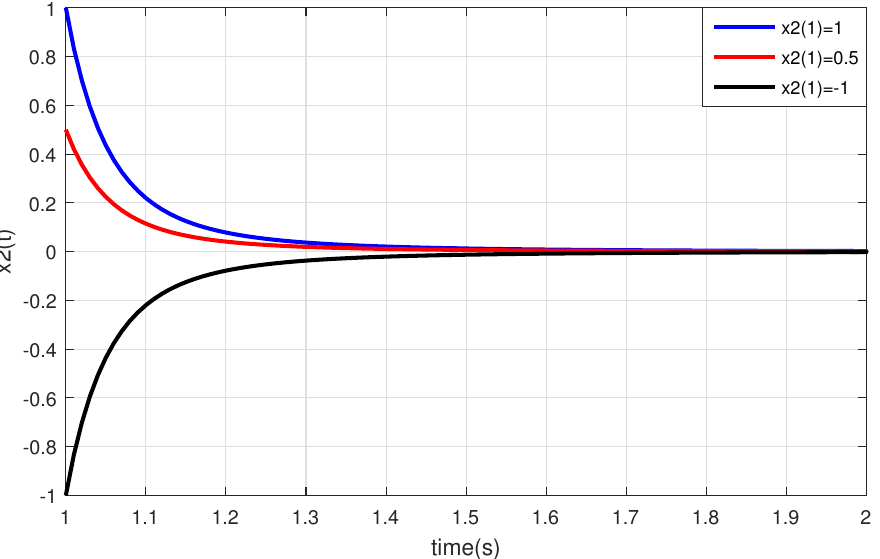
Figure 4. This figure shows that the solution x 2 ( t ) of the perturbed nonlinear system of DDEs (14) with three time-varying delays is bounded for h 1 ( t ) = 1 t ≥ 1, and different initial